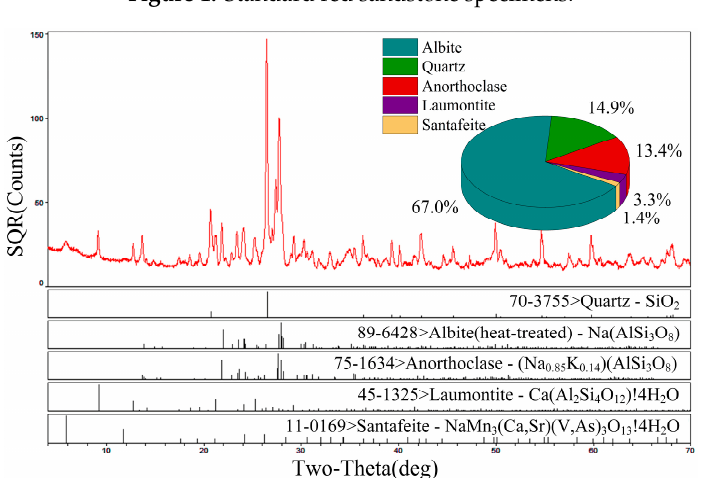
Figure 2. Composition analysis of the red sandstone specimens.